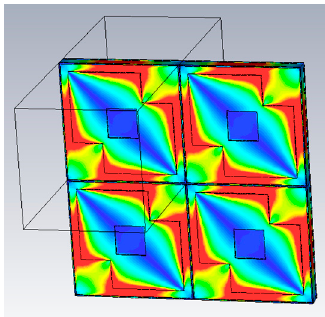
Figure 12. Electric field distribution with incident slant (xy) polarization at 0.91 THz frequency.